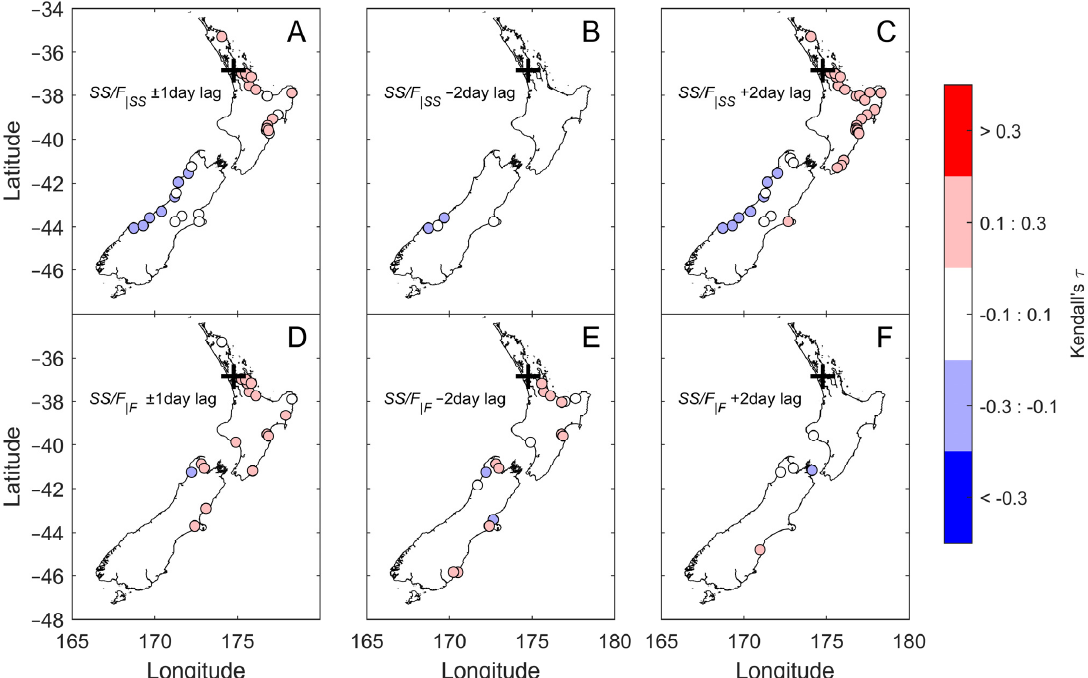
Figure 9. Lagged analysis Kendall’s rank correlation coefficient τ (color scale) calculated between skew-surge measured at Auckland and individual river-flow records. ( A ) SS/F | SS river-flow within ± 1-days of extreme skew-surge event; ( B ) SS/F | SS river-flow 2-days before extreme skew-surge event; ( C ) SS/F | SS river-flow 2-days after extreme skew-surge event; ( D ) SS/F | F skew-surge within ± 1-days of extreme river-flow event;€) SS/F | F skew-surge 2-days before extreme river-flow event; ( F ) SS/F | F skew-surge 2-days after extreme river-flow event.